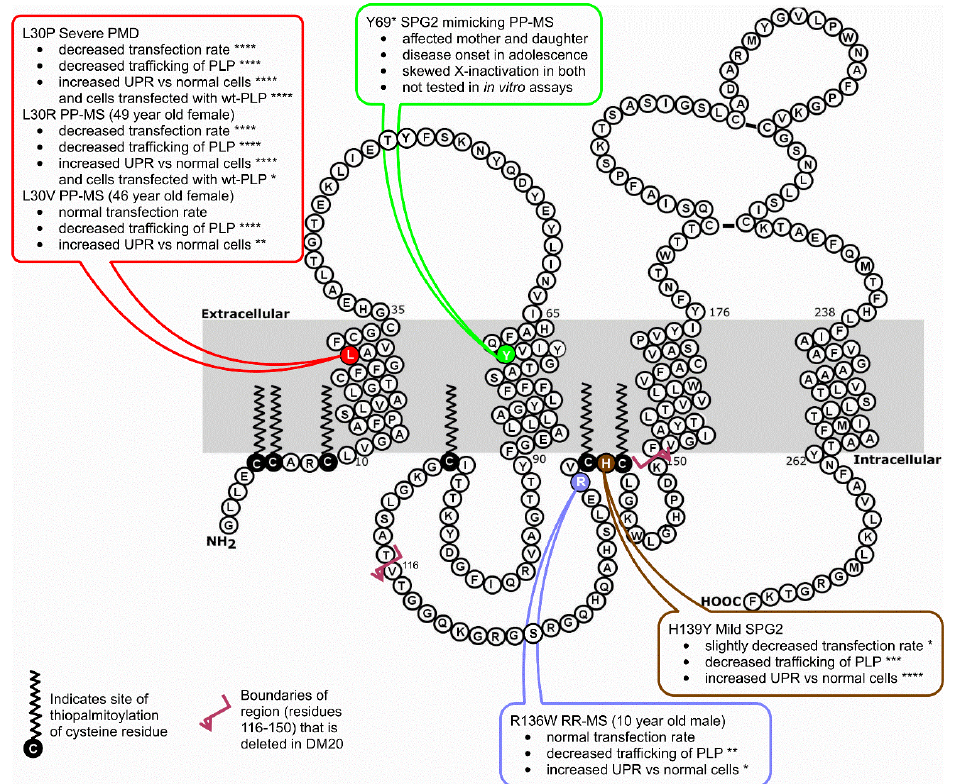
Figure 5. Diagram showing the orientation of PLP in the myelin membrane, the location of the mutations mentioned in this study, and, for those mutations tested in this study, a summary of their effects on Cos-7 cells, with the asterisks indicating the significance of the effects (* p < 0.05, ** p < 0.01, *** p < 0.001, **** p < 0.0001).